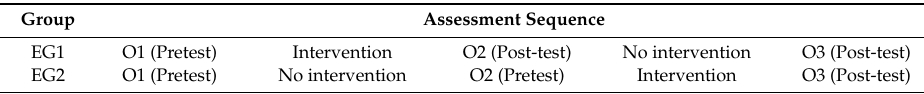
Table 1. The research